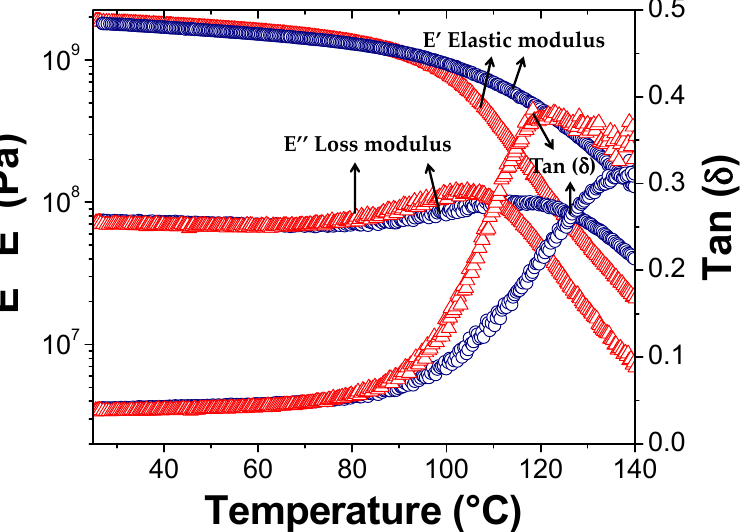
Figure 13. DMTA result of storage modulus (E (cid:48) ), loss modulus (E (cid:48)(cid:48) ) and tan ( δ ) of PKFUBISM/rGO 2.7% after molding ( (cid:52) ) and after the self-healing ( (cid:35)